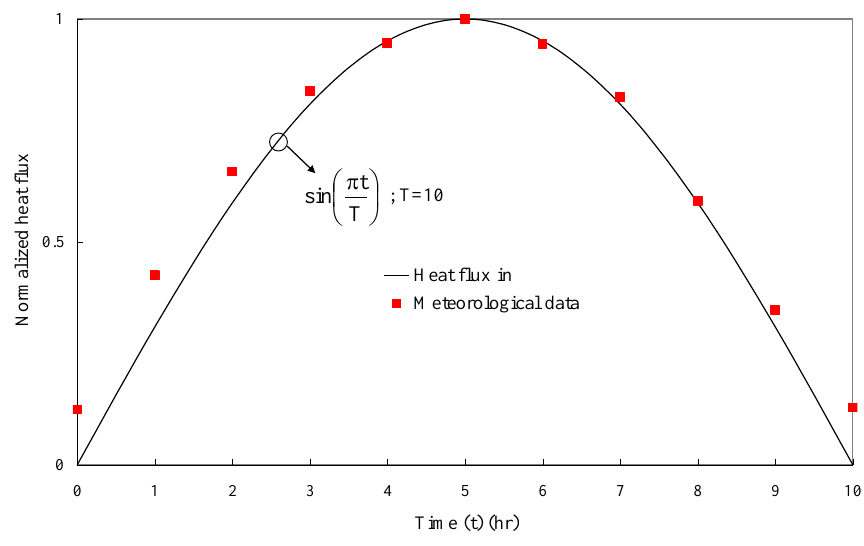
Figure 2. Normalized heating flux input and measured meteorological data.